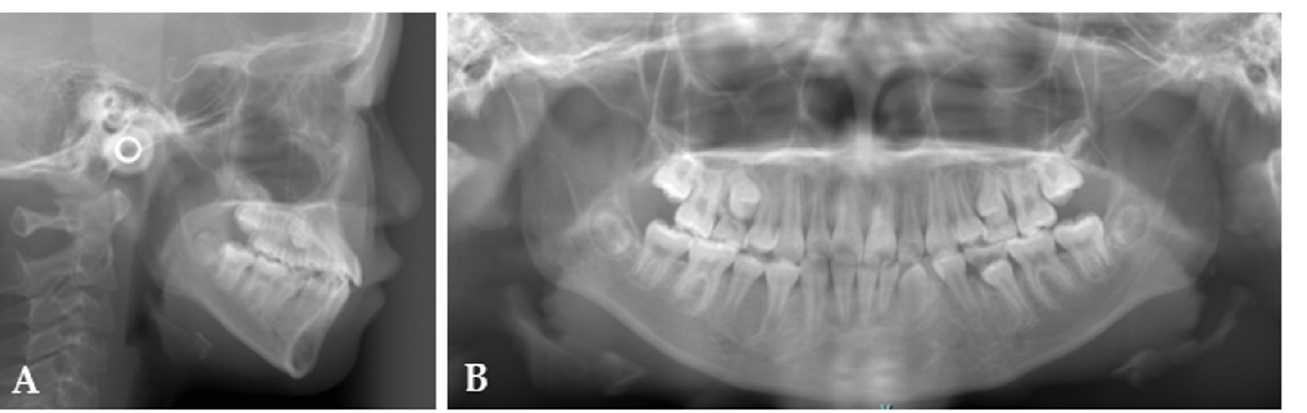
Figure 5. Six-month retention facial and intraoral photographs. ( A ) Lateral view; ( B ) frontal view; ( C ) right molar relationship; ( D ) centric occlusion; ( E ) left molar relationship; ( F ) overjet; ( G ) mirror view (maxillary); ( H ) mirror view (mandibular).